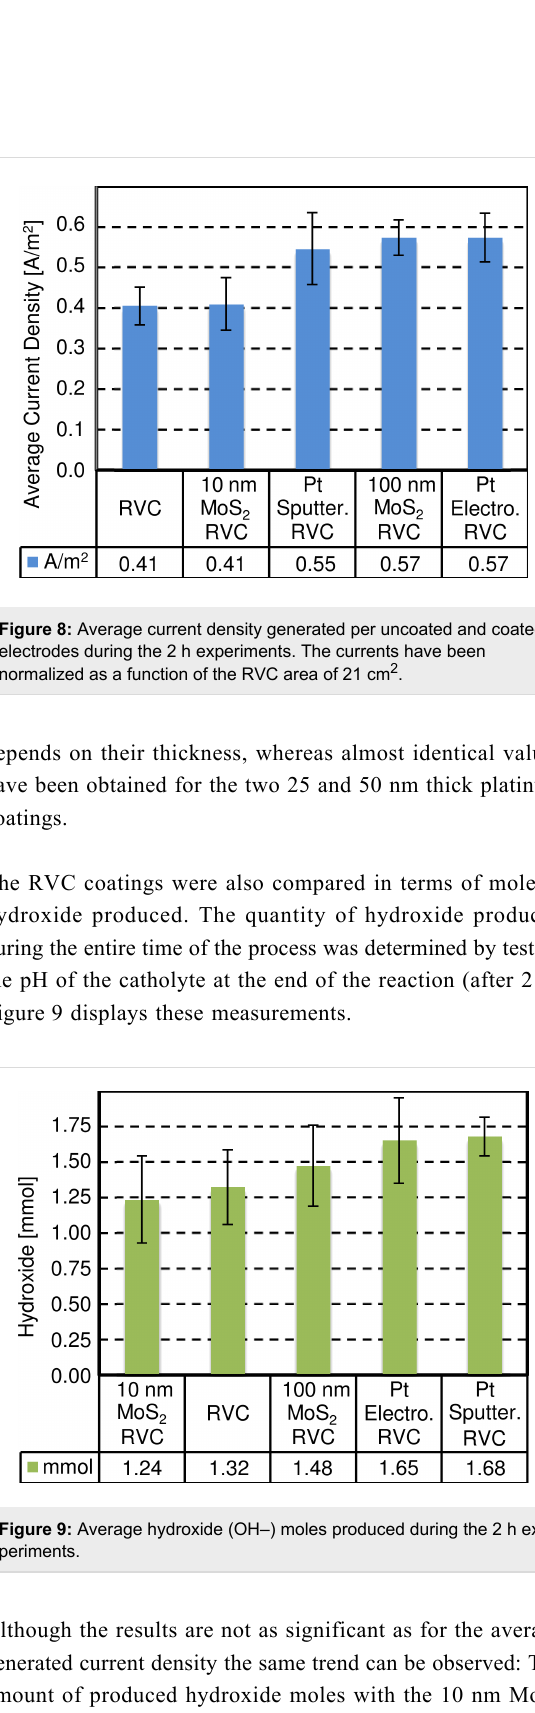
Although the results are not as significant as for the average generated current density the same trend can be observed: The amount of produced hydroxide moles with the 10 nm MoS 2 coating (1.24 mmol) is similar to the uncoated RVC (1.32 mmol). The 100 nm MoS 2 coating enhanced the hydrox- ide production to 1.48 mmol ( ≈ +12%). The best results